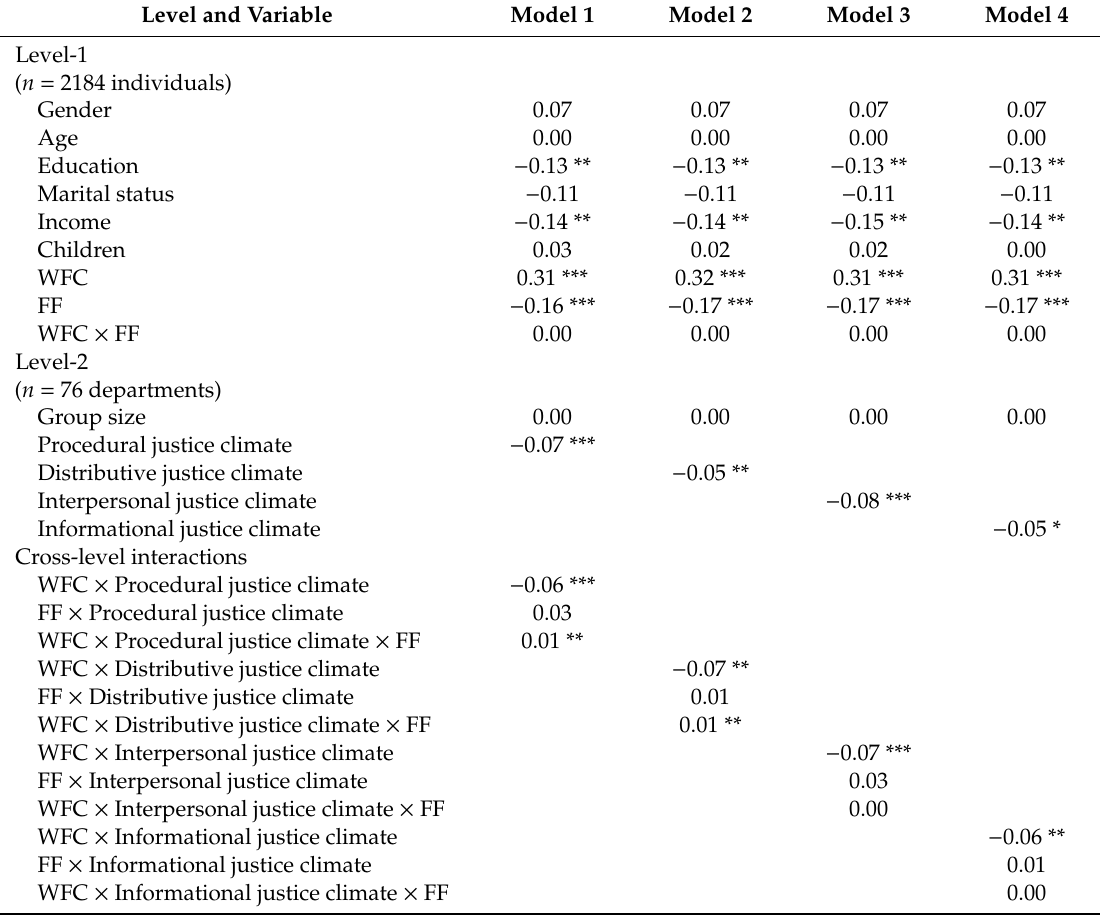
Table 3. Work-to-family conflict and depressive symptoms: Cross-level interactions of organizational justice climate and family flexibility.